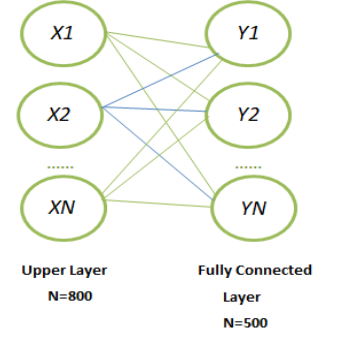
Figure 10 Backpropagation of the fully connected